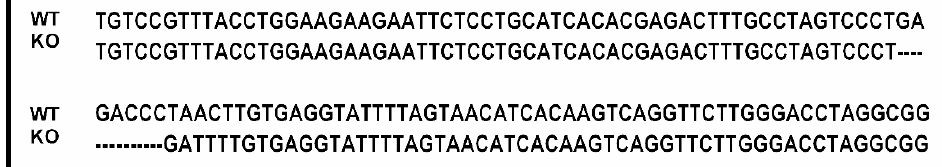
Figure 1. The sequences of wild type (WT) mice and miR-125b-2 knockout (KO) homozygous mice were compared using bio XM Software.